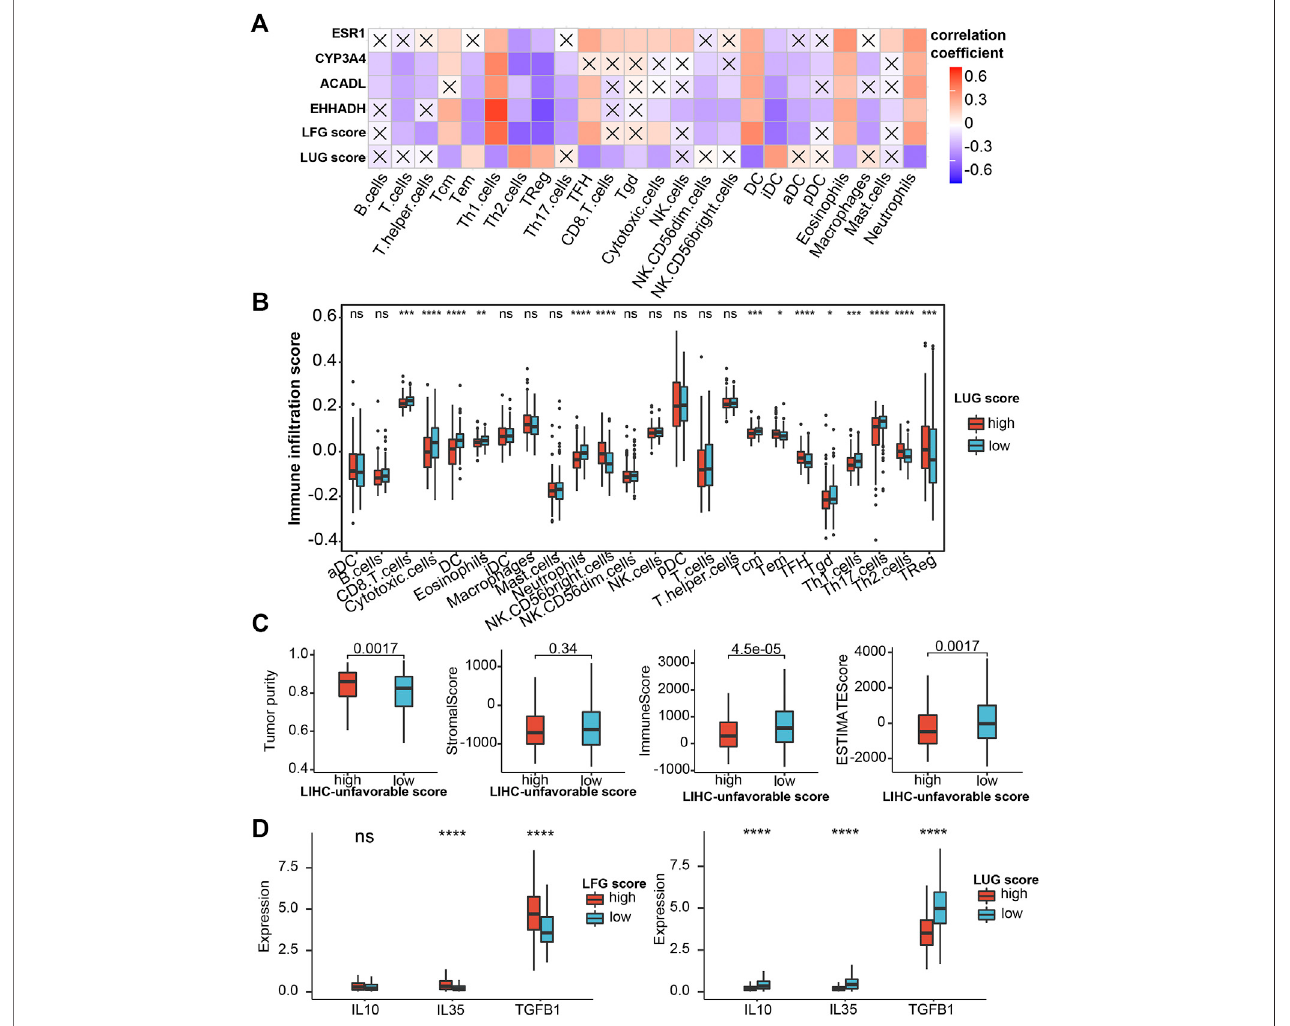
FIGURE 10 | Evaluation of immune in fi ltration (A) Correlation heatmap of LFG score, LUG score and key LCGs with 24 immune cells. The cross indicates no signi fi cance. (B) Immune in fi ltration scorein thehigh- and low-LUG scoregroup. (C) CorrelationsofLUG score withimmunescore,stromal score, ESTIMATEScoreand tumor purity. (D) Expression of the immune suppressive cytokines between high- and low-LUG/LFG score group. * p < 0.05, ** p < 0.01, *** p < 0.001, **** p < 0.0001.